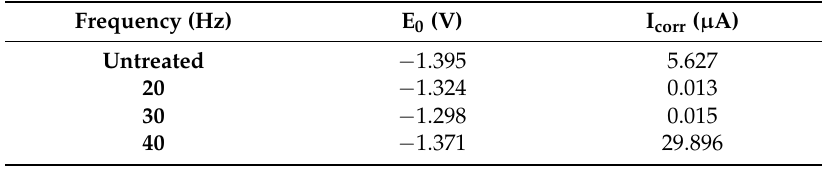
Table 5. Corrosion potential and corrosion current of the sample treated with the FB process.